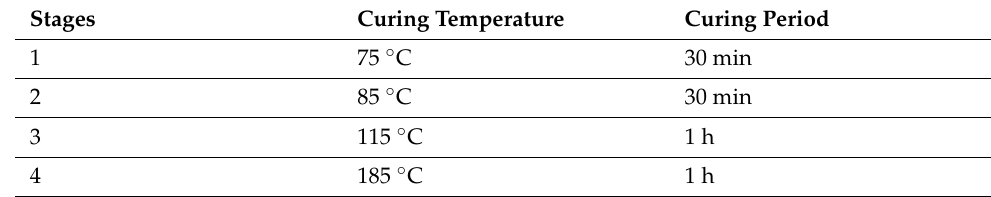
Table 2. Curing stages of SLS-printed